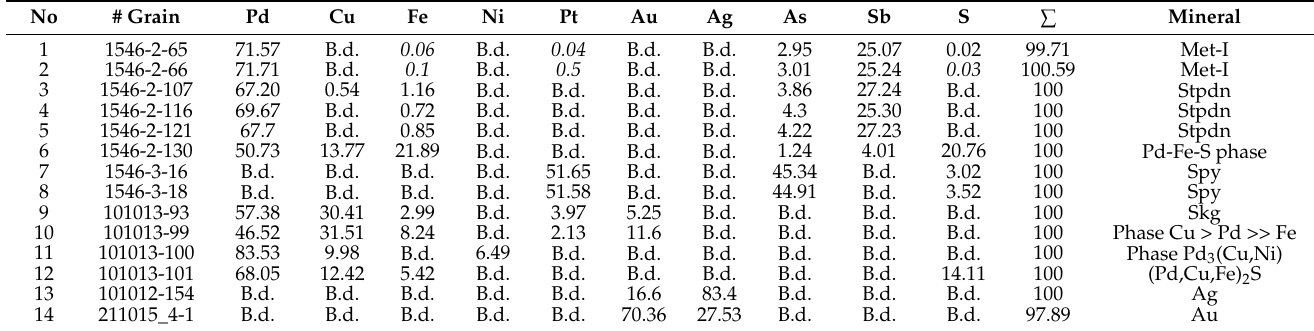
Figure 12. Noble metal minerals in clinopyroxenite III. ( a ) Crystals of palladium antimonide (Pd-Sb) on the surface of pyrite grain (Py); ( b ) Ag-Au particle (Au,Ag) (Table 10, No 14) in chalcopyrite (Ccp) at the contact of two pyrite (Py) grains. Table 10. Chemical composition of noble metal minerals in clinopyroxenites (in